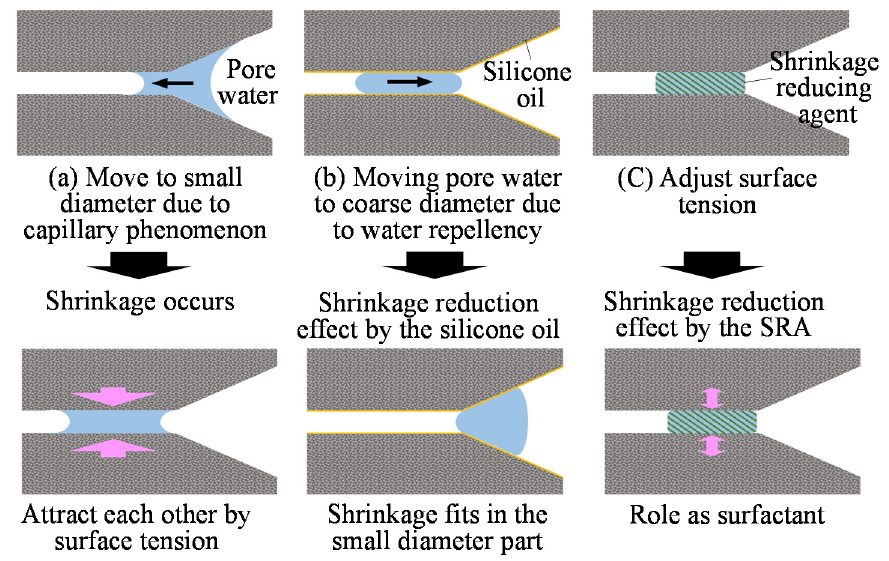
Figure 15. Shrinkage reduction effect.